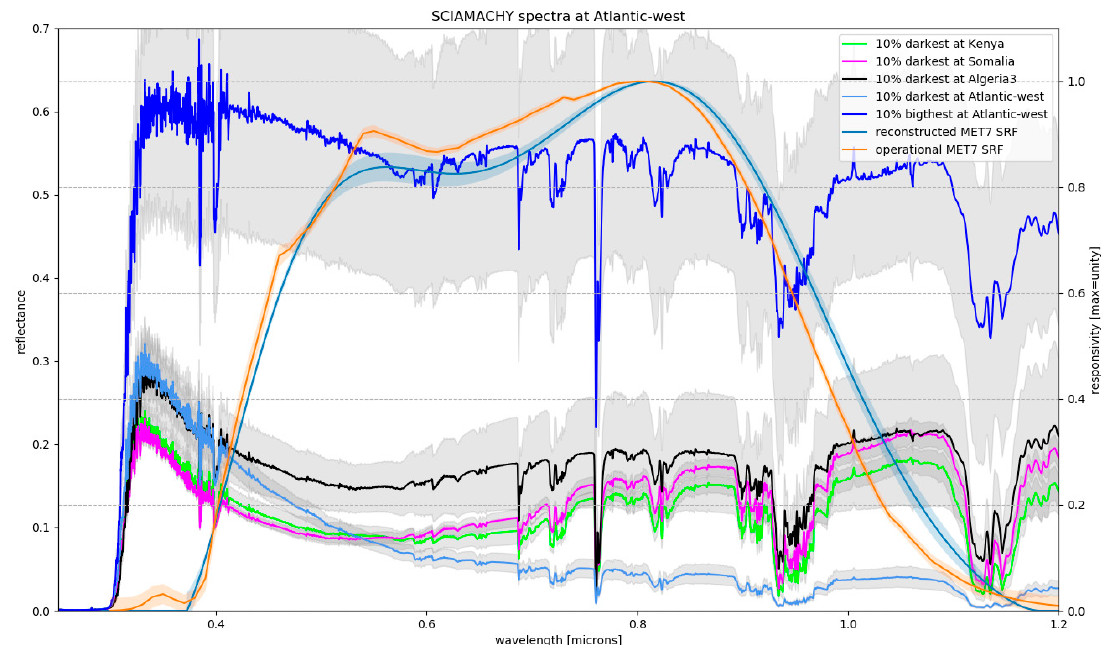
Figure 17. Spectral characteristics of the collocation regions and of Algeria-3 collected during 10 days of February 2005. In order to emphasise on cloud-free surfaces a set of 10% of the darkest spectra was averaged for each region. For the Atlantic site also a set of the 10% brightest spectra was averaged to illustrate the spectral shape of cloudy observations. The grey shading indicates the standard deviation of each set.